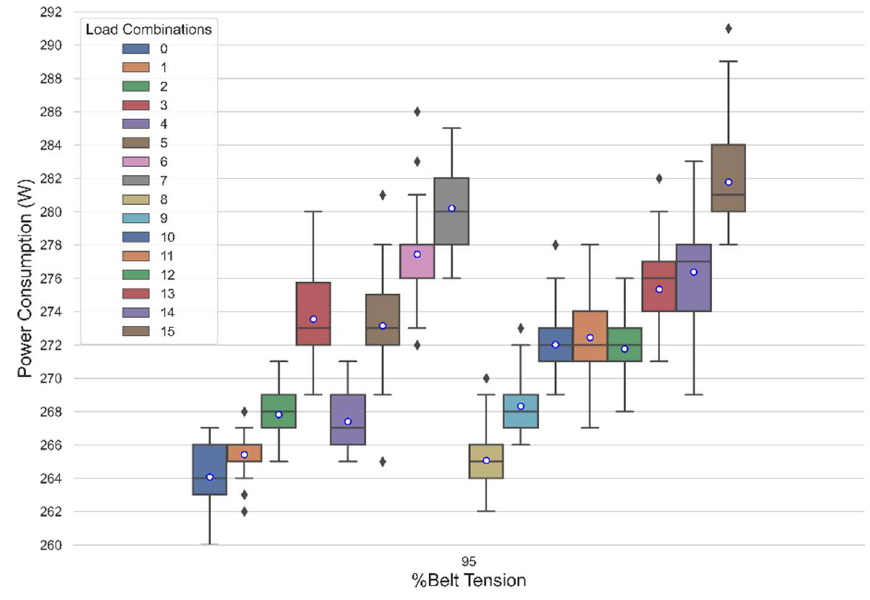
Figure 10. Effect of 95% belt tension and load on conveyor motor driver power consumption. Tables 7 and 8 show the dynamic case results for 95% belt tension with and without active zones. The dynamic case results for this belt tension were better than the dynamic case results obtained for 75% and 85% belt tensions. For 95% belt tension, it took 4.6 s for a pallet to move from Z1 to Z5. Table 7. Dynamic case results for 95% belt tension without active zones. Belt Tension (%)